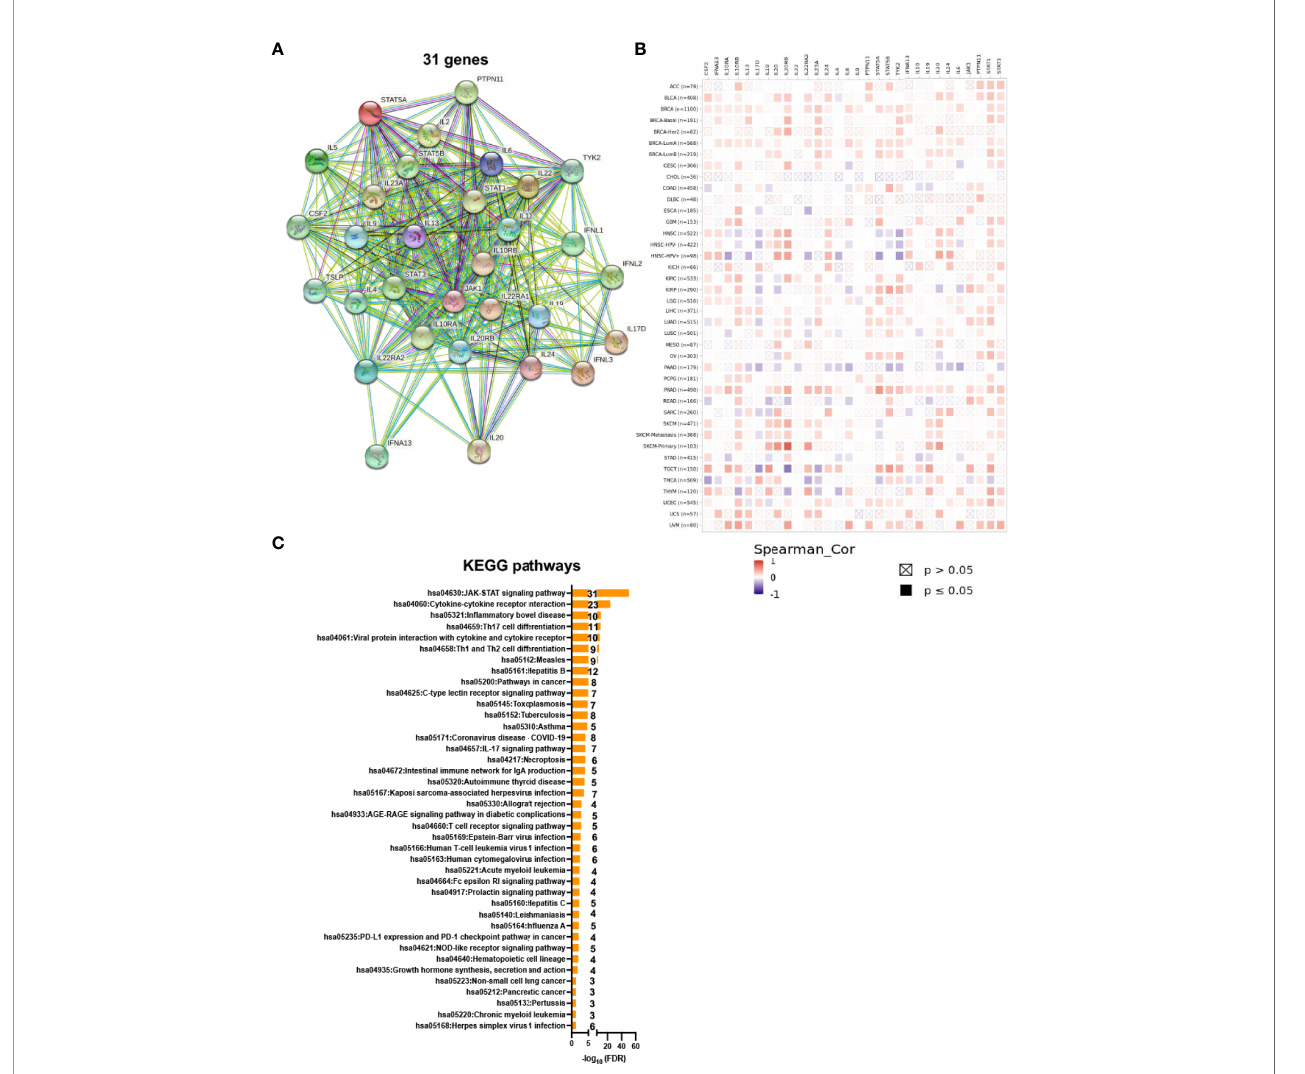
FIGURE 2 | IL22RA1-associated genes are involved in the JAK-STAT signaling pathway. A total of 30 genes were related with IL22RA1 based on https://www. ndexbio.org/iquery/. (A) Network showing protein-protein interaction for the 31 genes. (B) Correlation between genes related with IL22RA1 and IL22RA1 in multiple cancers. (C) Function analysis of these 31 genes based on Kyoto Encyclopedia of Genes and Genomes (KEGG) pathways using DAVID. Signi fi cant pathways shown (FDR < 0.05) with gene number for each